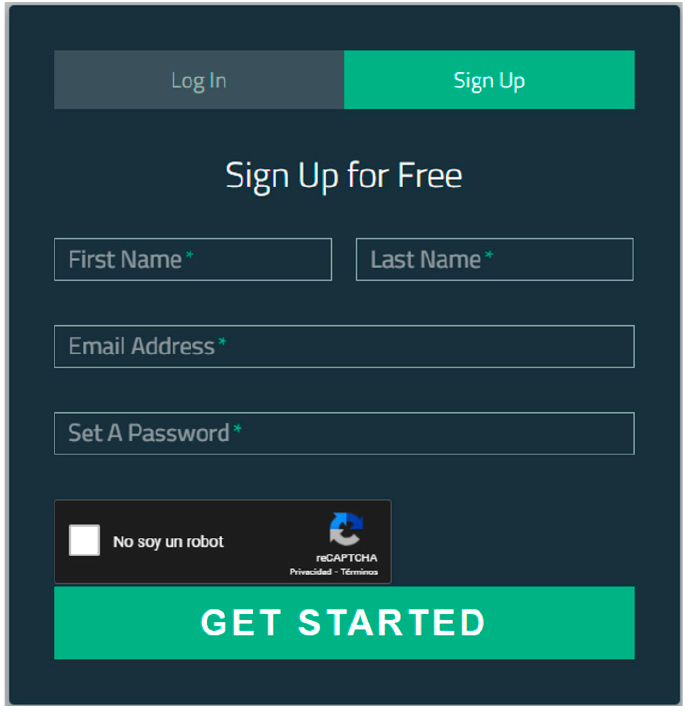
Figure A1. Snapshot of SALVAL configuration step 1. “*” stands for mandatory fields. (2) Specify the product being validated and the reference products. Select from the existing database of products or import new products.